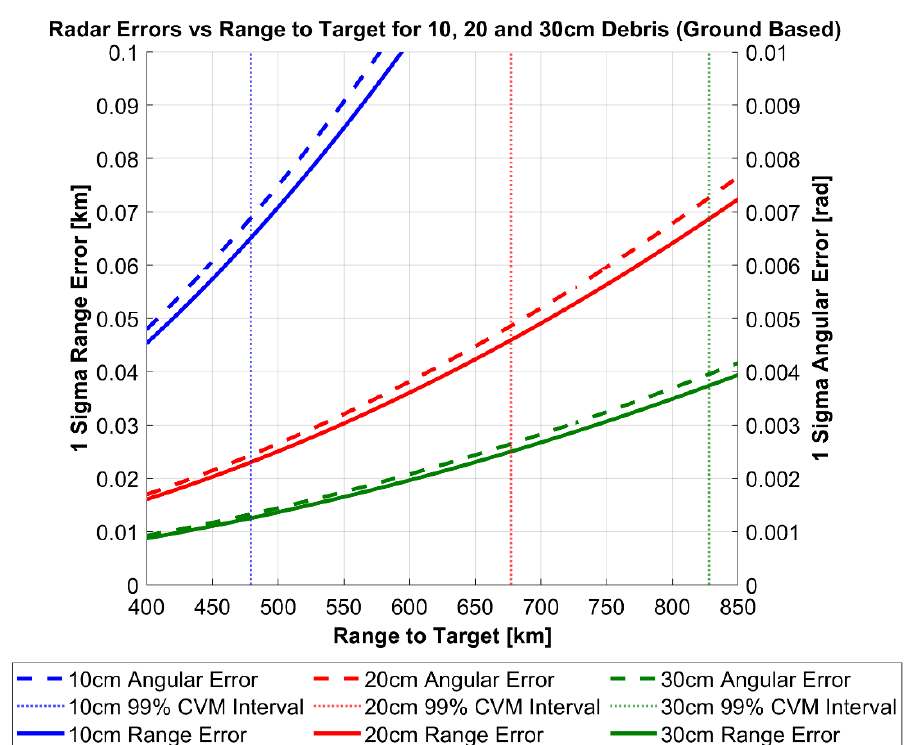
Figure 9. Space Based Radar range and angular errors as a function of range to target.